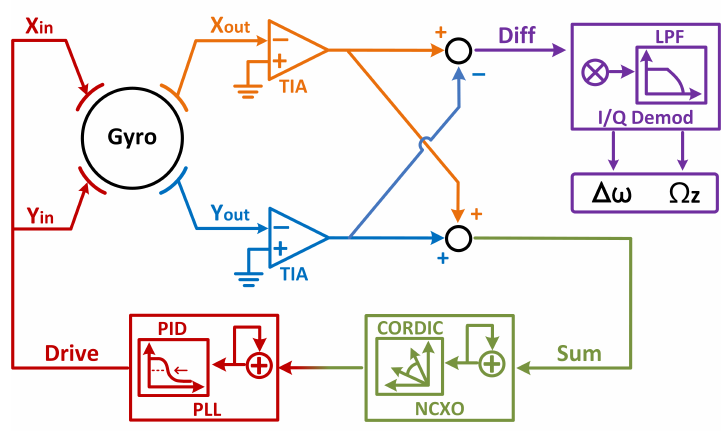
Figure 1. The schematic of the dual-mode gyroscope